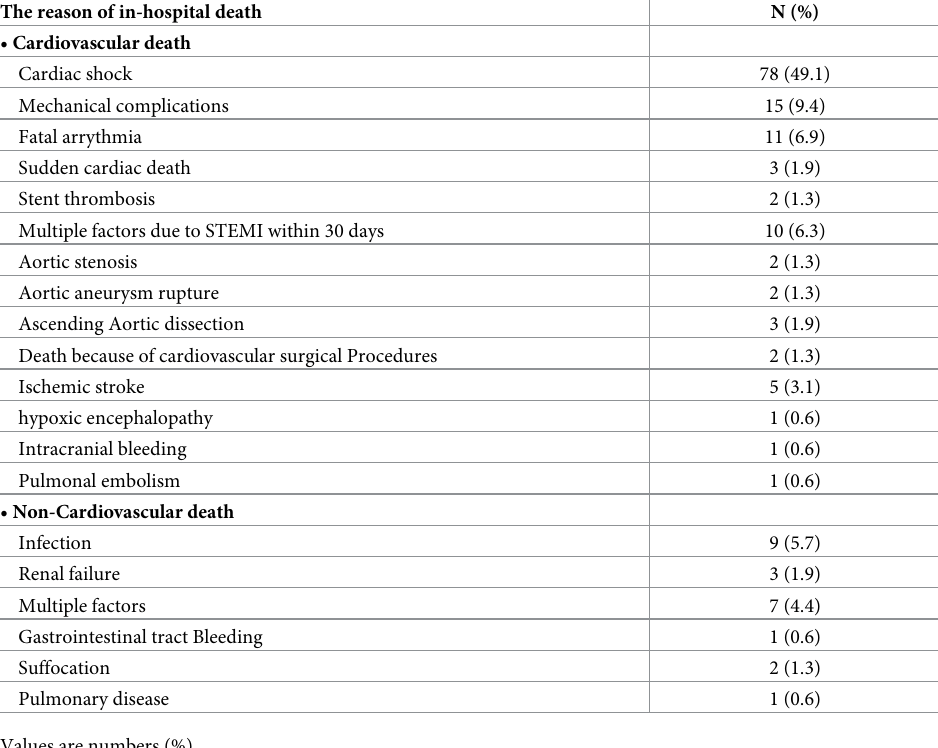
Table 3. Cause of in-hospital death (n = 159).